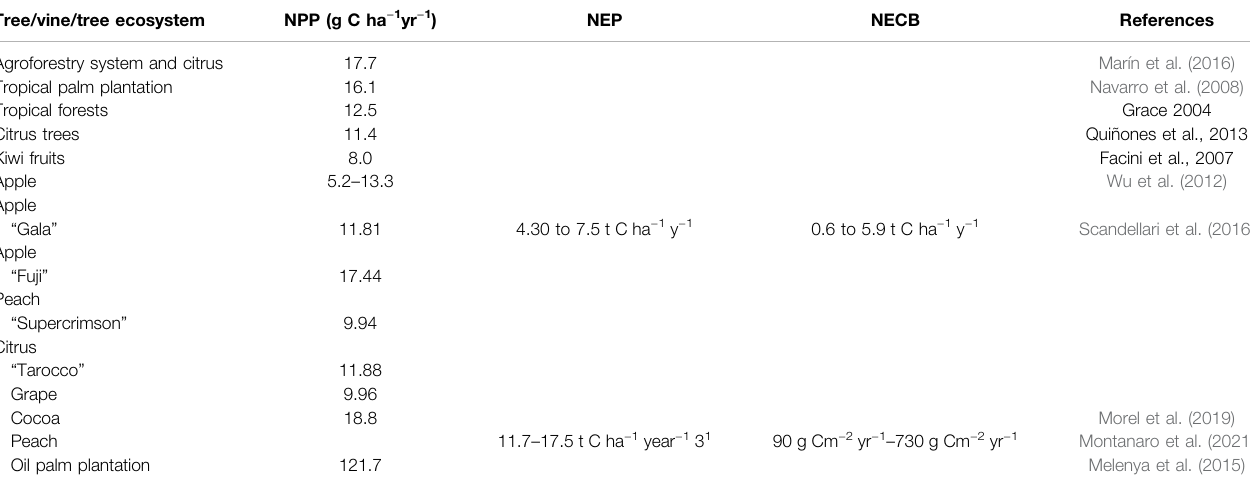
TABLE 1 | Carbon fi xation (NPP, NEP, and NECB) by different fruit tree orchards. Tree/vine/tree